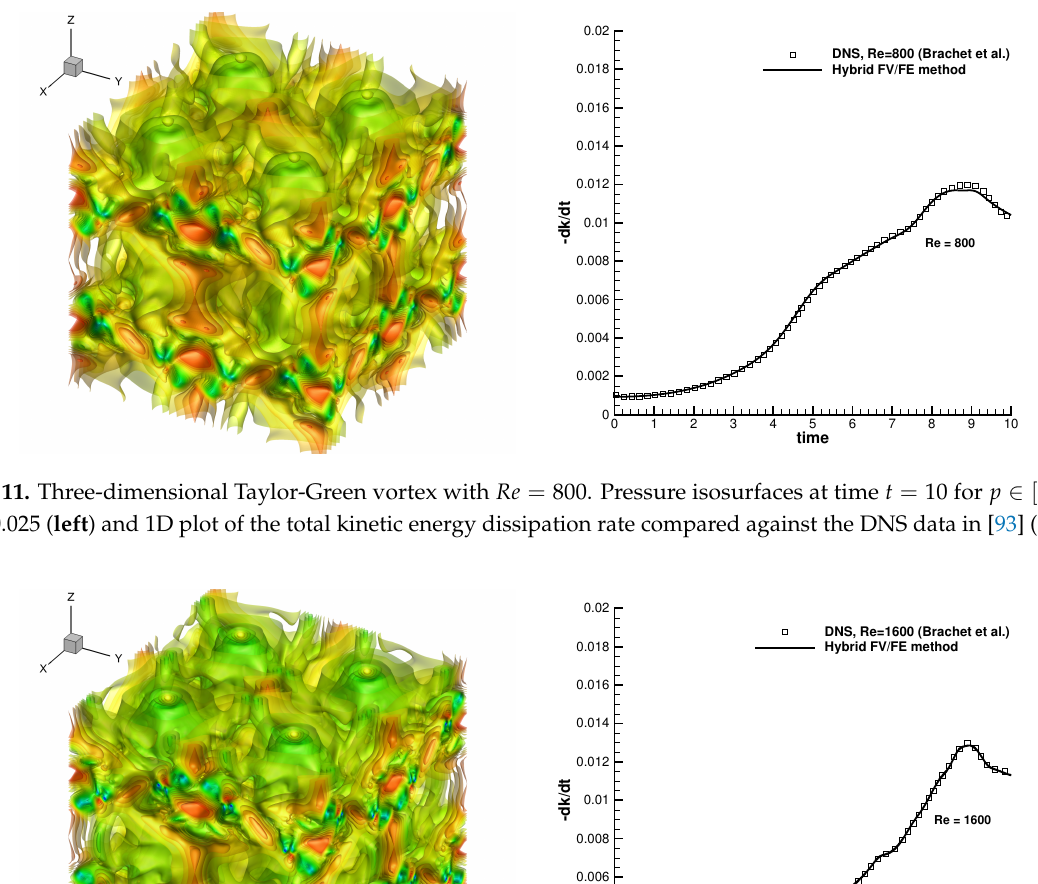
Figure 10. Three-dimensional Taylor-Green vortex with Re = 400. Pressure isosurfaces at time t = 10 for p ∆ p = 0.025 ( left ) and 1D plot of the total kinetic energy dissipation rate compared against the DNS data in [93] ( right ).